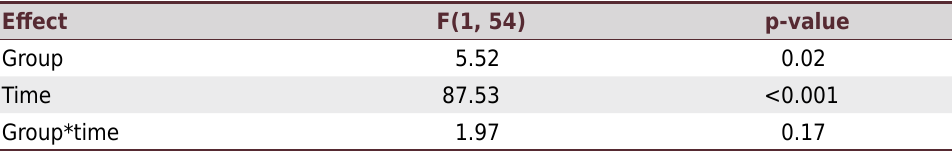
Table 3. A repeated-measure two-way analysis of variance (ANOVA) for soil knowledge Effect